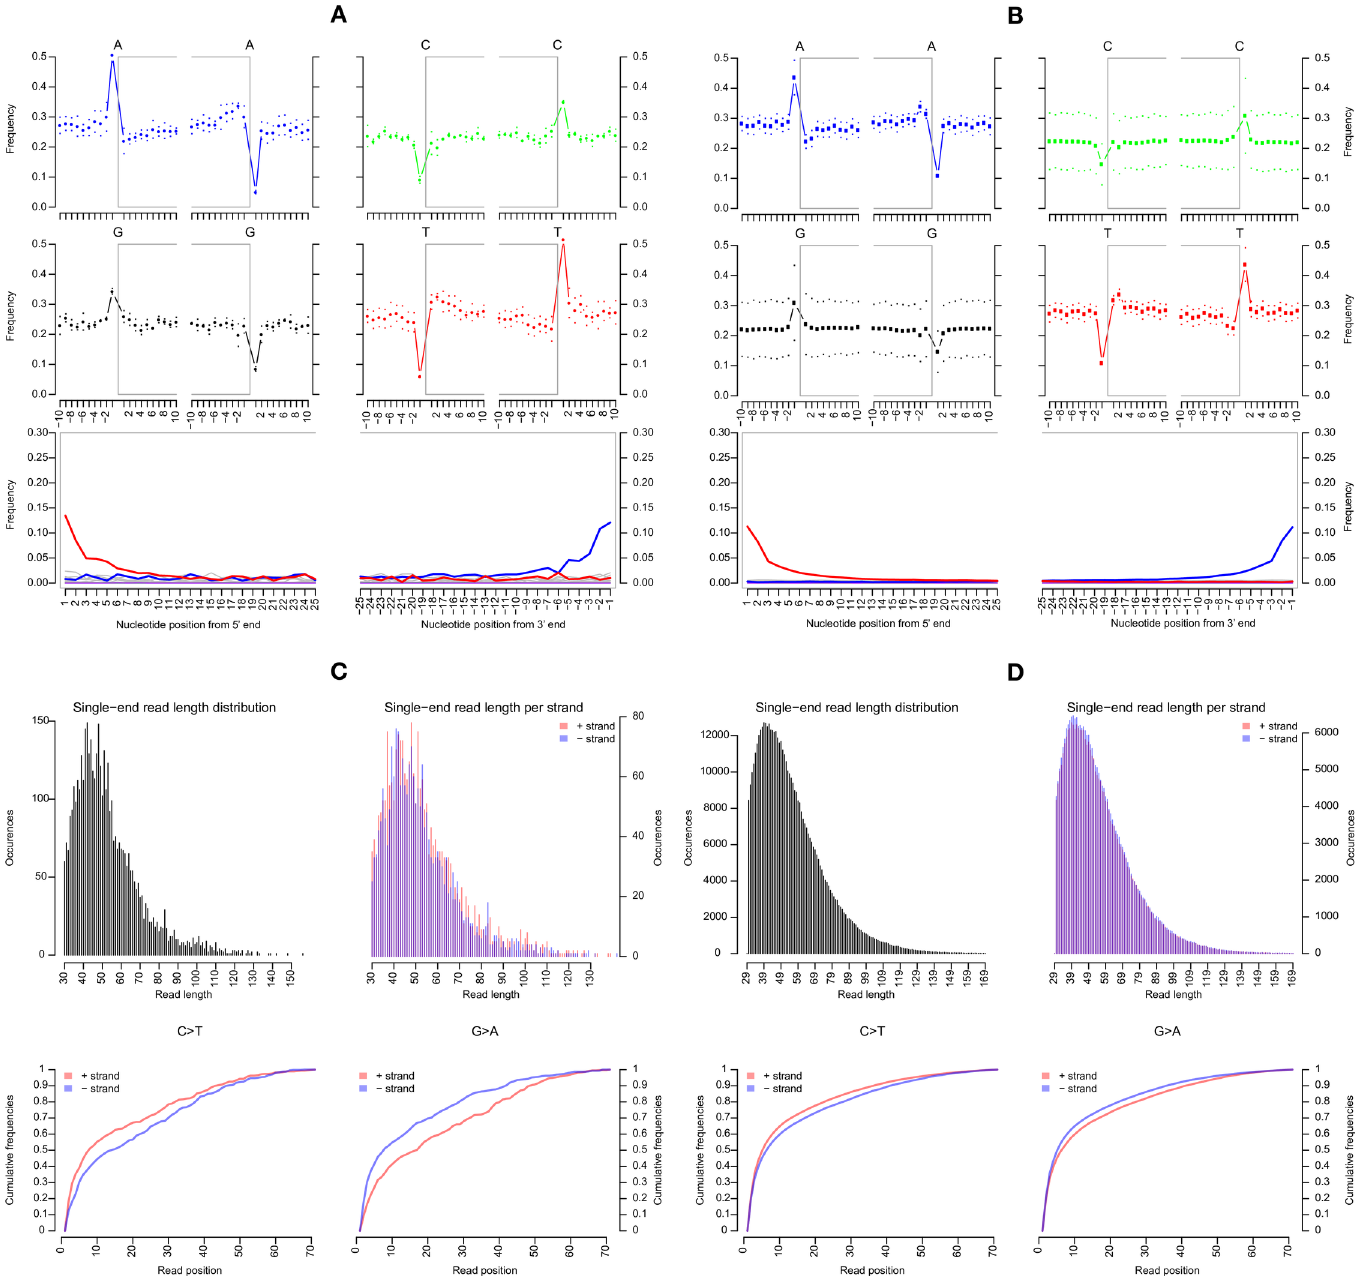
Fig 3. Damage patterns of NASD24HBV and mtDNA sequenced reads. Next-generation sequencing reads from non-UDGtreated distal femur extraction (LM1) were analyzedfor nucleotide deamination patterns followingremovalof reads less than 30 nt in lengthand after mappingof remainingreads. The upper plots displaythe nucleotide base frequency with the grey box indicatingfrequency within the read. The bottom plots show the position’s specific substitutions from the 5’ (left) and the 3’ end (right) of each fragment. (A) Deamination plots for processedreads from NASD24 LM1 enrichedfor HBV and as mapped to HBV reference sequenceX65257. (B) Deamination plots for processedreads from NASD24 LM1 enrichedfor humanmtDNA and as mappedto mtDNA reference sequenceNC_012920. (C) Fragment length distribution plot for HBV reads. (D) Fragment length distributionplot for mtDNA reads.